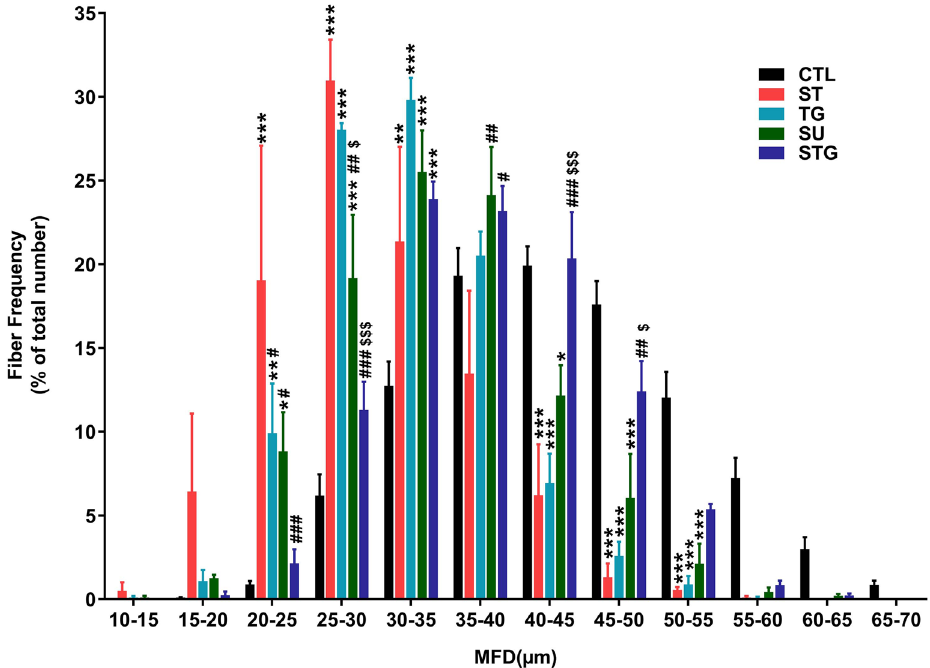
Figure 6. Effect of different transection models on muscle fiber distribution. Quantitative muscle fiber size distribution from the MFD value (µm) in each group as a percentage of total fiber number. n = 3/group; * P < 0.05, ** P < 0.01, *** P < 0.001 vs. uninjured (CTL), # P < 0.05, ## P < 0.01, ### P < 0.001 vs. ST, and $$$ P < 0.001 vs. TG. For other details, see Fig.